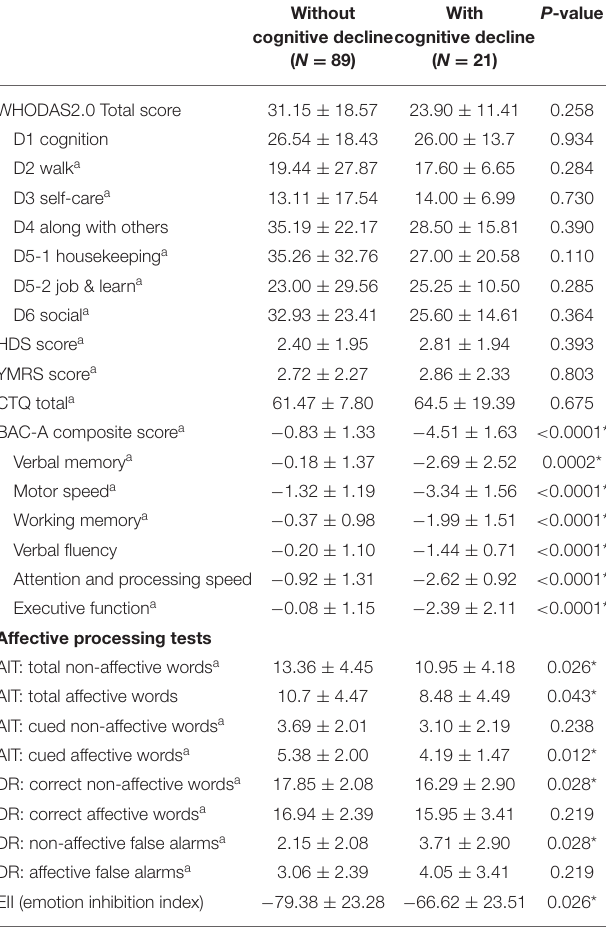
TABLE 2 | Mood status, functional assessment and cognitive profiles at follow-up in BD patients with and without cognitive decline. Figure 2 demonstrated correlations between cognitive and P -value Without With subjective functional domains in patients with ( Figure 2A ) and cognitive decline cognitive decline ( N = 89) ( N = 21) without cognitive decline ( Figure 2B ). We evaluated whether there was the same trend of correlations for both groups of WHODAS2.0 Total score 31.15 ± 18.57 BD, where better cognitive scores were correlated to